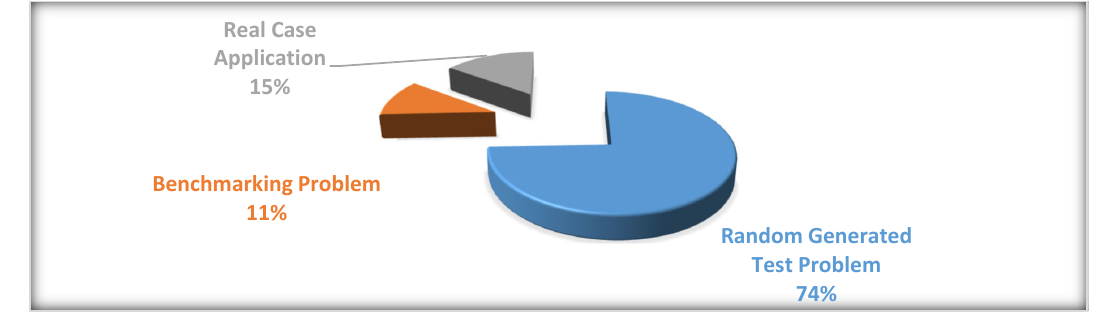
Fig. 19. Percentage distribution of HFS articles according to test instances